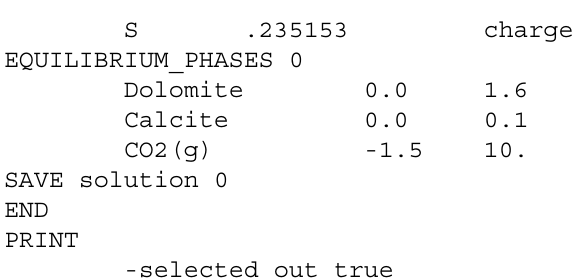
Table 37. Input file for example